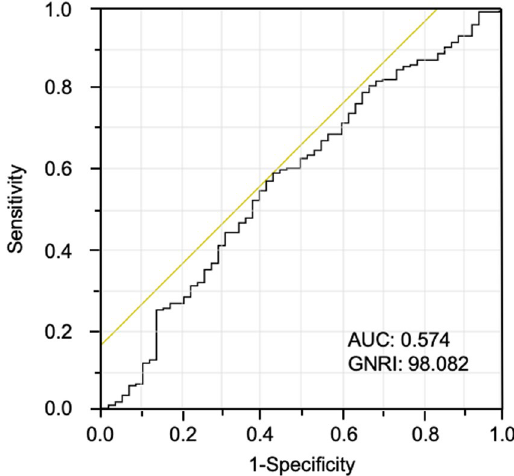
Figure 2. Receiver operating characteristic (ROC) curve analysis of GNRI for overall survival in elderly patients with colorectal cancer. The ROC curve shows that the optimal cut-off value of GNRI is 98.082. Area under the curve for GNRI is 0.574. The sensitivity is 0.591, and the specificity is 0.569.